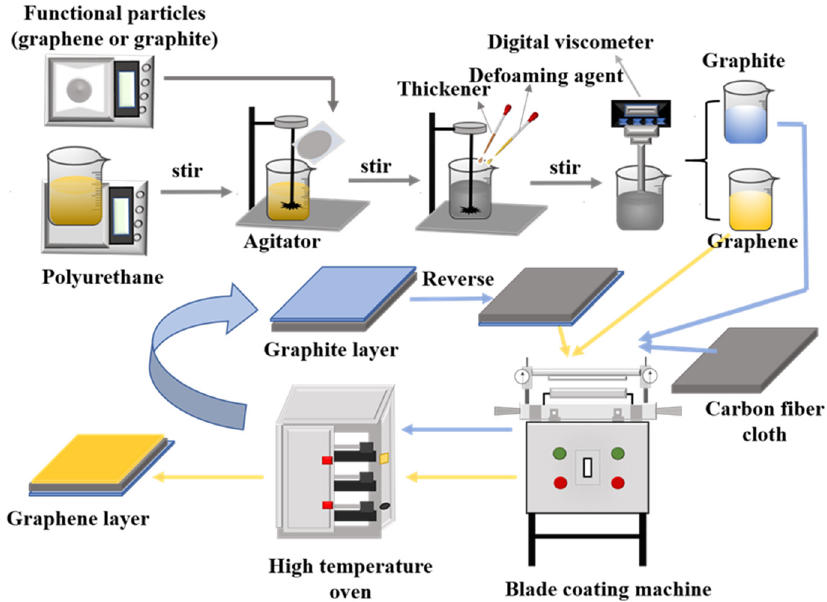
Figure 1. The simple methods for preparing the flexible sandwich structure of carbon fiber cloth.